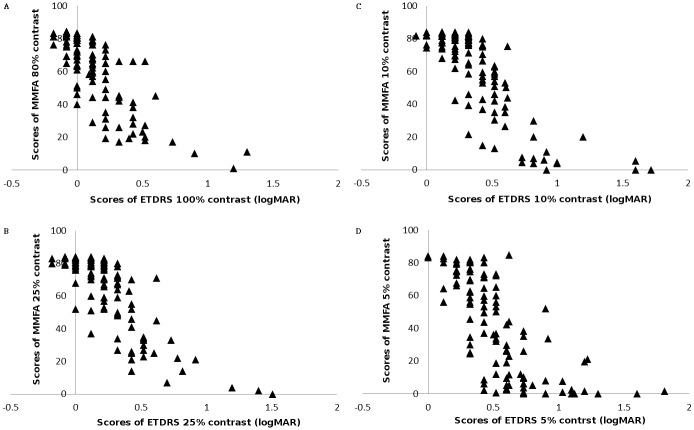
Scatter graphs demonstrating the correlations between the MMFA and EDTRS contrast acuity charts.High to moderate correlations shown at (a) high (100% for EDTRS charts, 80% for MMFA), (b) 25%, (c) 10%, and (d) 5% contrast levels.